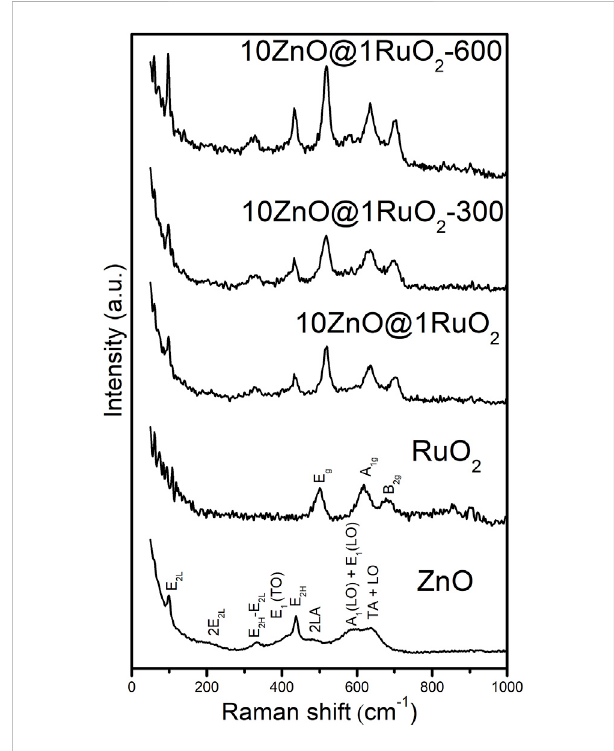
FIGURE 4 Raman spectra of the catalyst